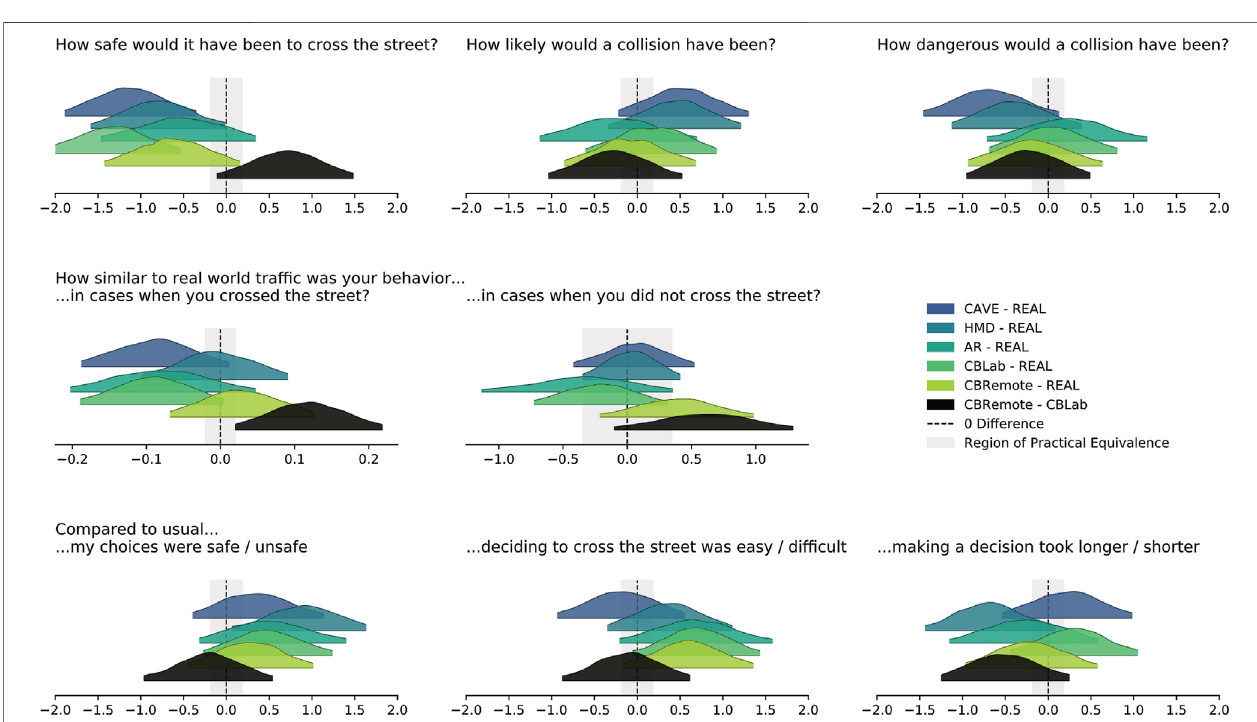
FIGURE 11 | Difference in posterior estimates for each of the subjective items in the questionnaire (cf. Figure 10 ). The results for Q1-3 and Q6-8 in the upper and lower rows are given in logits, the results of Q5 in the center plot on a log scale.